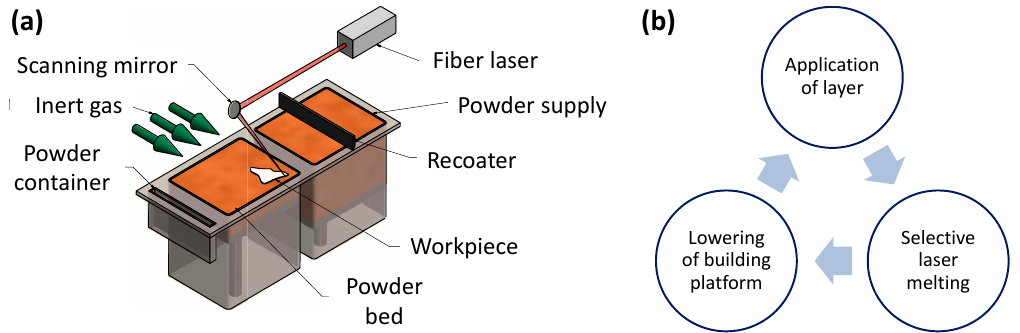
Figure 1. Machine set-up for powder bed fusion of metals (PBF-LB / M) ( a ); iteratively repeated processing steps ( b ).